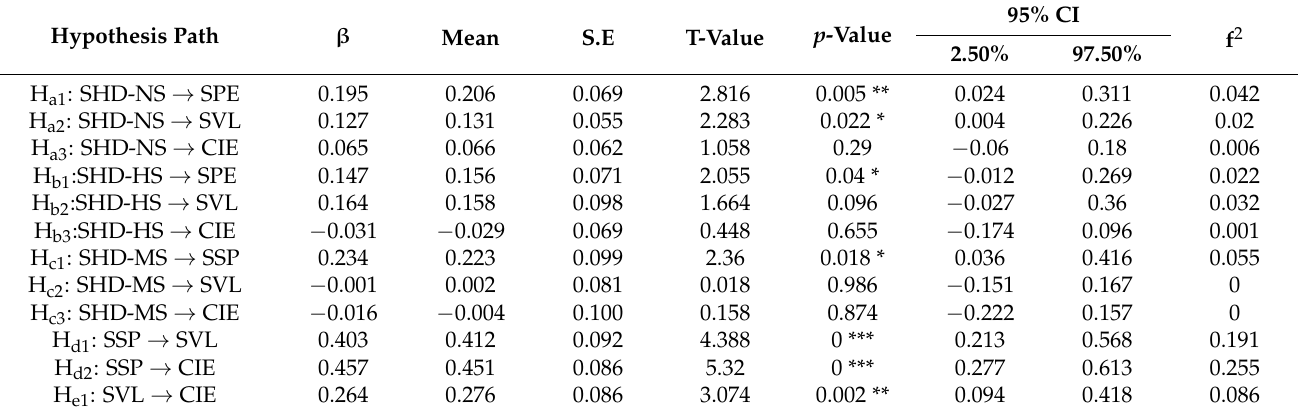
Table 6. Testing of hypothesis paths in the structural equation model.